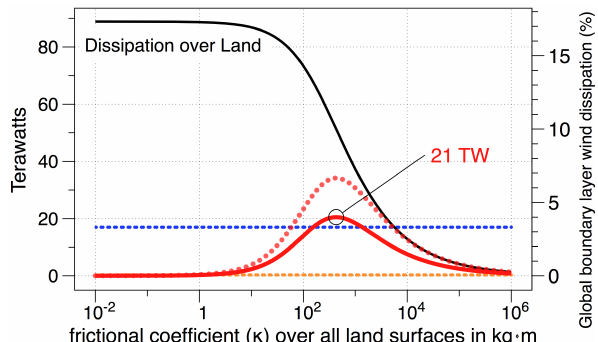
Fig. 3. The relationship between an increased frictional coefficient ( κ ) to changes in wind dissipation over land (black line), extracted wind power (dashed red), and mechanical power that drives the wind turbine (solid red) is shown for the simple momentum balance model. For reference, the dashed blue horizontal line shows the es- timated 17 TW of global energy demand in 2009 (EIA, 2009) and the dashed orange horizontal line indicates the estimated 0.03 TW of global electricity production by wind turbines in 2008 (World Wind Energy Association, 2008).